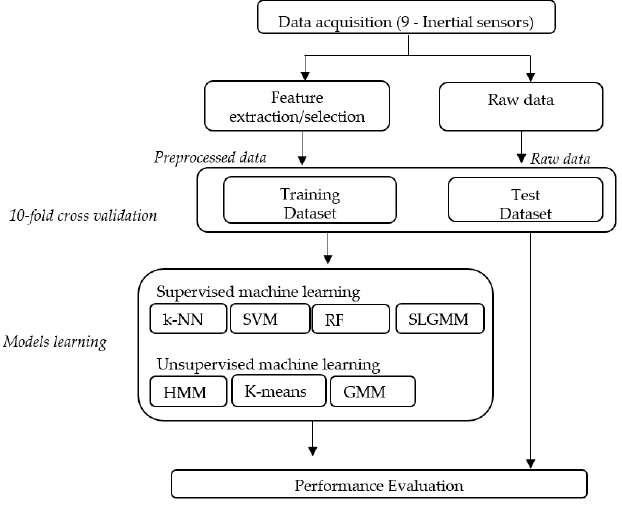
Figure 3. Steps of human activity recognition.